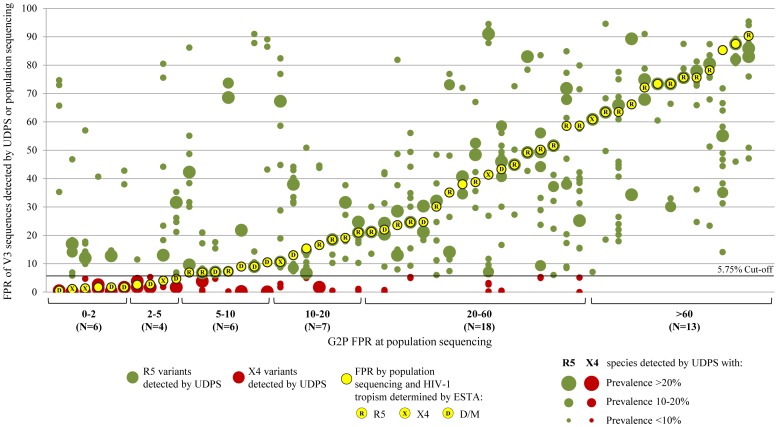
The graph reports the distribution of FPR values of all the V3 variants detected by UDPS in each patient according to FPR ranges at population V3 sequencing.The relative dimension of green and red dots represents the prevalence of R5 and X4 species detected by UDPS. Yellow dots represent the FPR determined by population sequencing and letters within dots indicate the phenotypic tropism determined by ESTA (R =  pure CCR5 tropism, X = pure CXCR4 tropism, D = dual/mixed tropism. For blank yellow dots, ESTA result was not available. A FPR of 5.75 has been used as cut-off to infer HIV-1 co-receptor usage of V3 sequences obtained by both V3 population and ultra-deep sequencing.